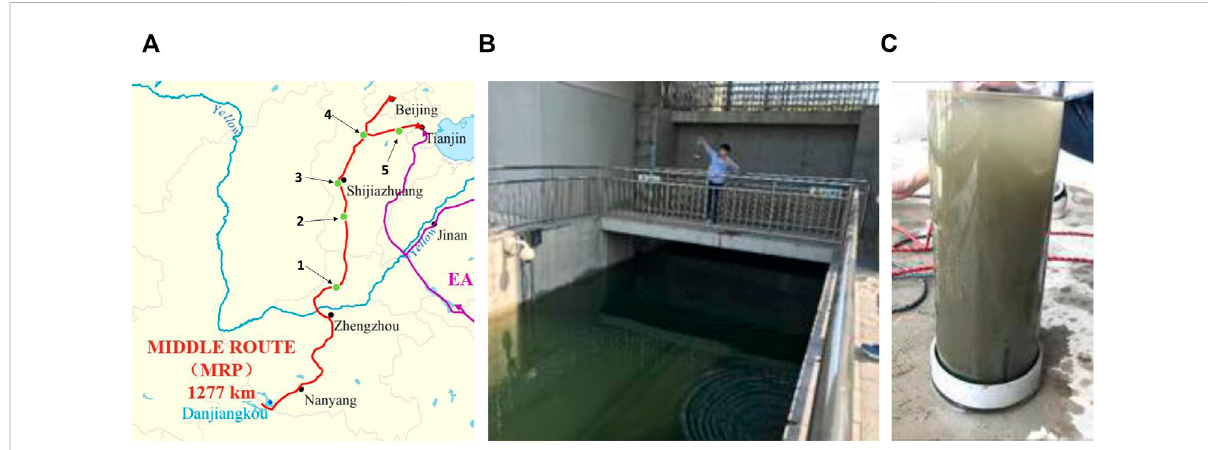
FIGURE 5 The siltation sampling. (A) the position: 1. the inverted siphon at Qi River in Hebi city, Henan Province; 2. the inverted siphon at Liyang River in Xingtaicity,HebeiProvince;3.theinvertedsiphonatXiaoRiverinShijiazhuangcity,HebeiProvince;4.thewaterdivisionatXiheimountaininBaoding city, Hebei Province; 5. theoutlet sluice atWaihuan River in Tianjin. (B) Sampling site photo atthe outlet sluiceat Waihuan River in Tianjinand (C) the photo of the sample in the sampling